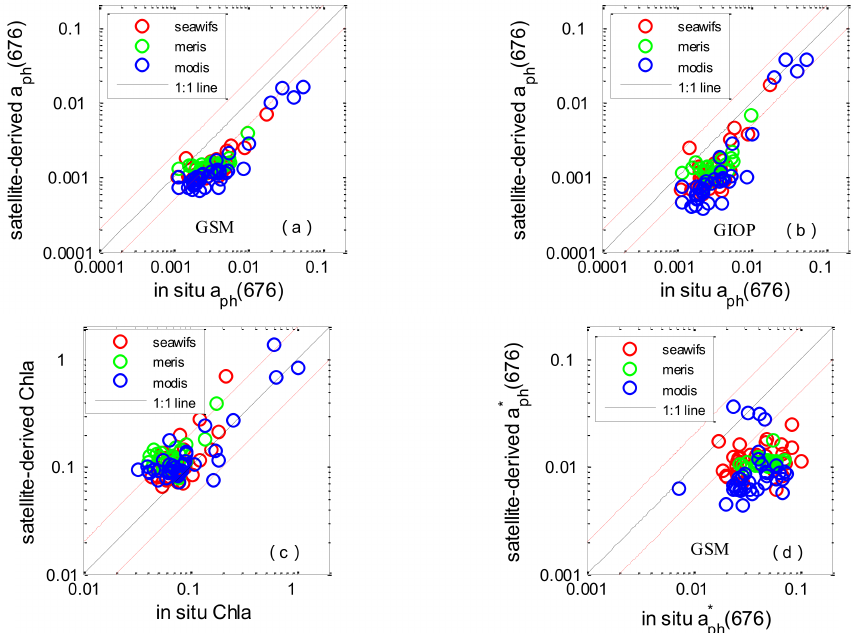
Figure 7. Scatter plots of satellite-derived values versus in situ measurements in the SCS: GSM derived a ph (676) ( a ); GIOP-derived a ph (676) ( b ); Chl-a ( c ); GIOP-based a * ph (676) ( d ). The solid line is the 1:1 line. The red dashed lines are the 1:2 and 2:1